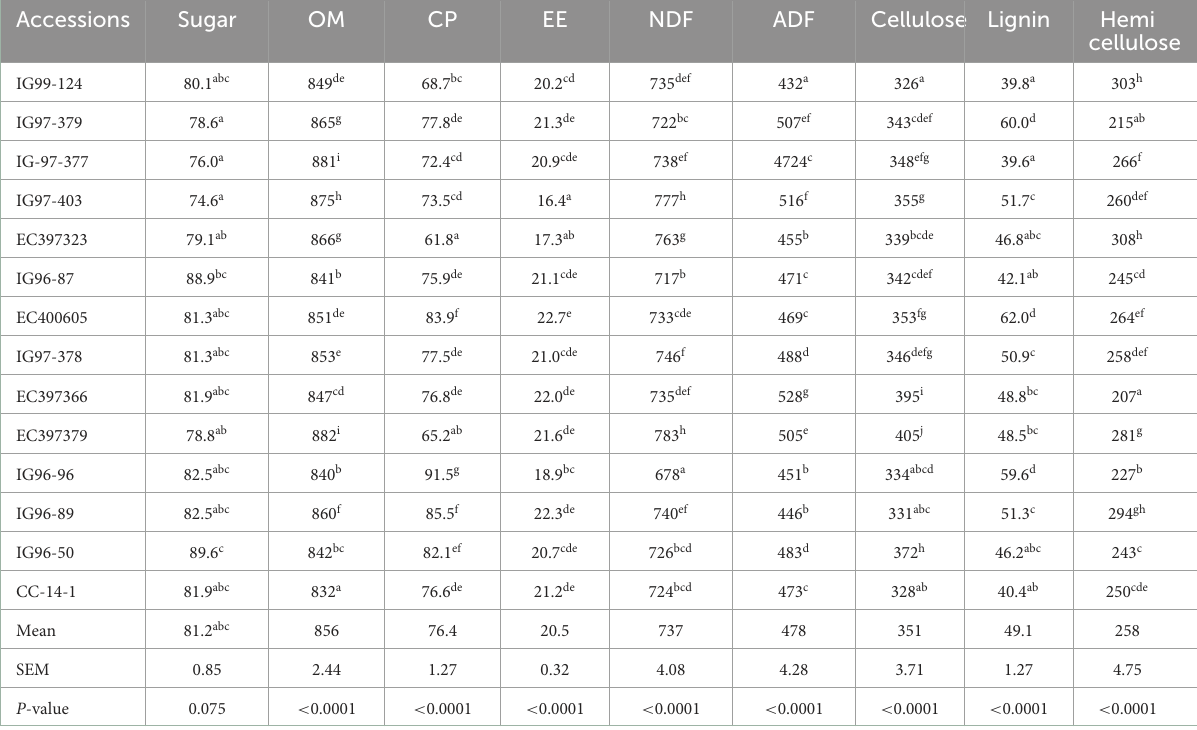
TABLE 2 Sugar contents (mg g − 1 DM) and chemical composition (g kg − 1 DM) of sugar-rich Cenchrus ciliaris genotypes.